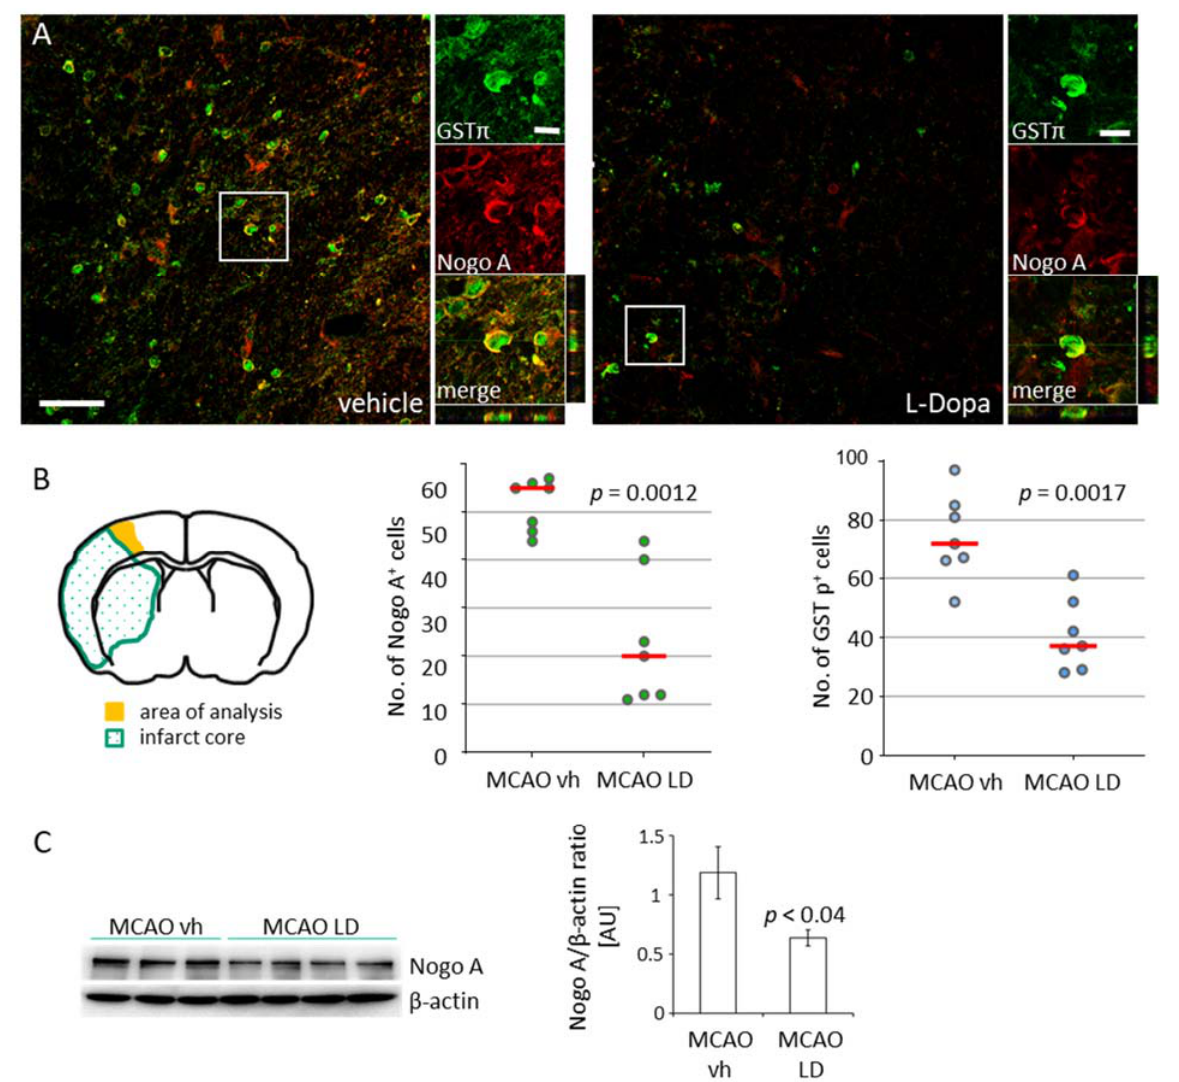
Figure 3. Downregulation of Nogo A by treatment with levodopa. ( A ) Co-staining for Nogo A (red, Cy3) and glutathione- S-transferase π (GST π , green, AF488) in the peri-infarct area of rats treated either with saline (vehicle) or levodopa (LD 20 mg/kg) 14 days after tMCAO; scale bars: low magnification 50 µm, high magnification 10 µm. ( B ) Illustration of the peri-infarct area (yellow) used for analyses and the number of Nogo A and GST π positive cells ( n = 7, each experimental group) in this region. Statistical analysis was performed by the Mann–Whitney test. ( C ) Levels of Nogo A in the peri-infarct area in rats treated either with vehicle ( n = 7) or levodopa ( n = 8) and semi-quantitative analysis of bands after normalization against beta-actin. Statistical analysis was performed by the Student’s t -test. p value < 0.05 was considered significant and differences are shown in respective figures.